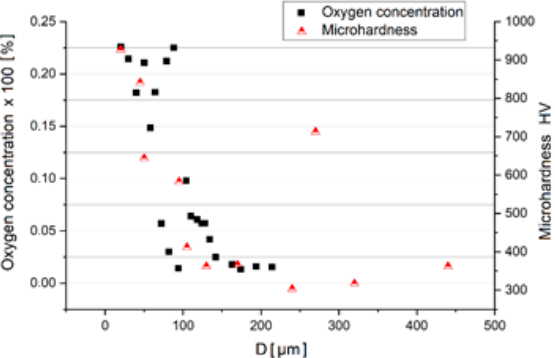
Figure 6. Correlation between oxygen content and microhardness values for isothermal oxidized sample 60 min at 1050 °C .